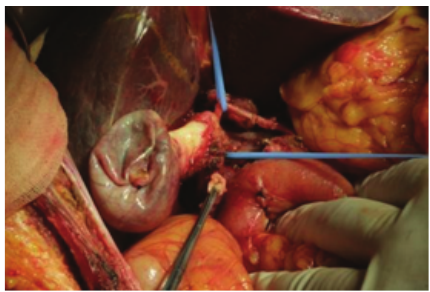
Figure 3: Trim the right hepatic artery proximally and distally after resection of the tumor and affected artery.